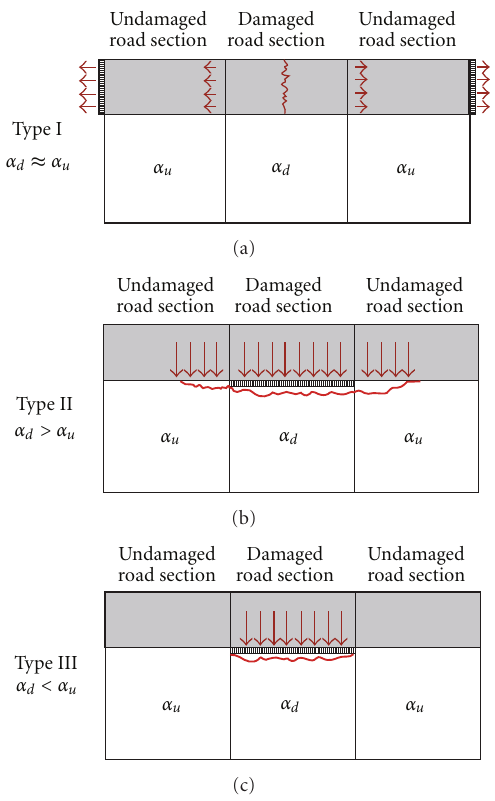
Figure 8: The three types of road section degradation.